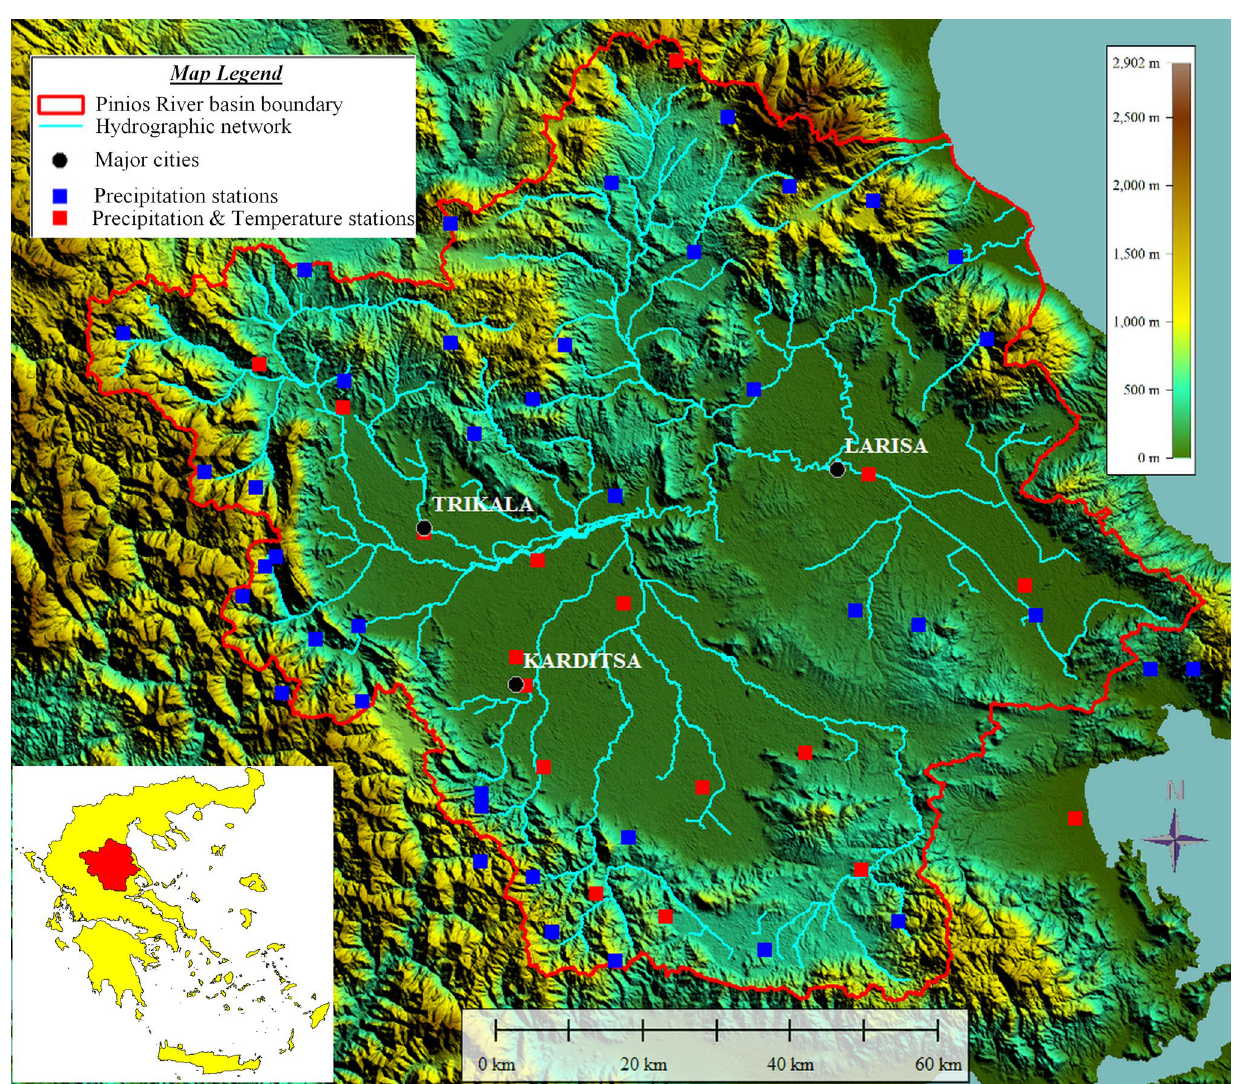
Fig. 1 Location map of the study